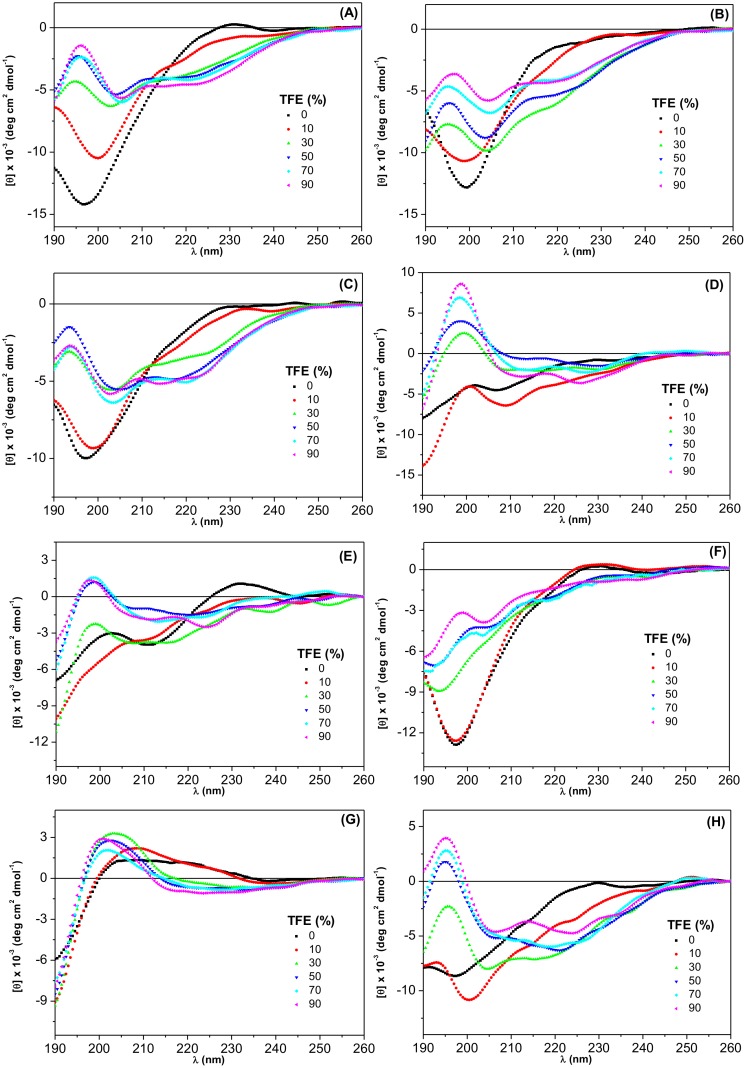
CD spectra of AngI (A), TOAC0-AngI (B), TOAC1-AngI (C) TOAC3-AngI (D), TOAC5-AngI (E), TOAC8-AngI (F), TOAC9-AngI (G) and TOAC10-AngI (H) as a function of TFE concentration.